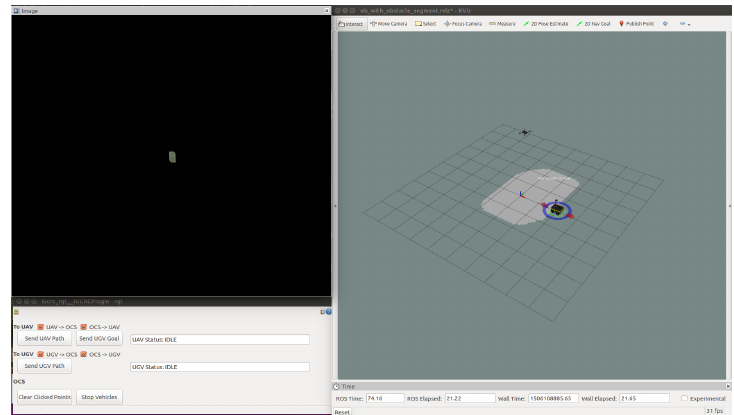
Figure 4. A sample image of the operator control station (OCS) presented to the user. The right hand window is an RViz window displaying the robots, cost maps, and paths. The image window in the upper left-hand corner visualizes the assembled image of the ground plane. The control widget in the lower left-hand corner displays the current status of the vehicles and their comms bridges. This interface allows goals to be specified and planned paths to be visualized before